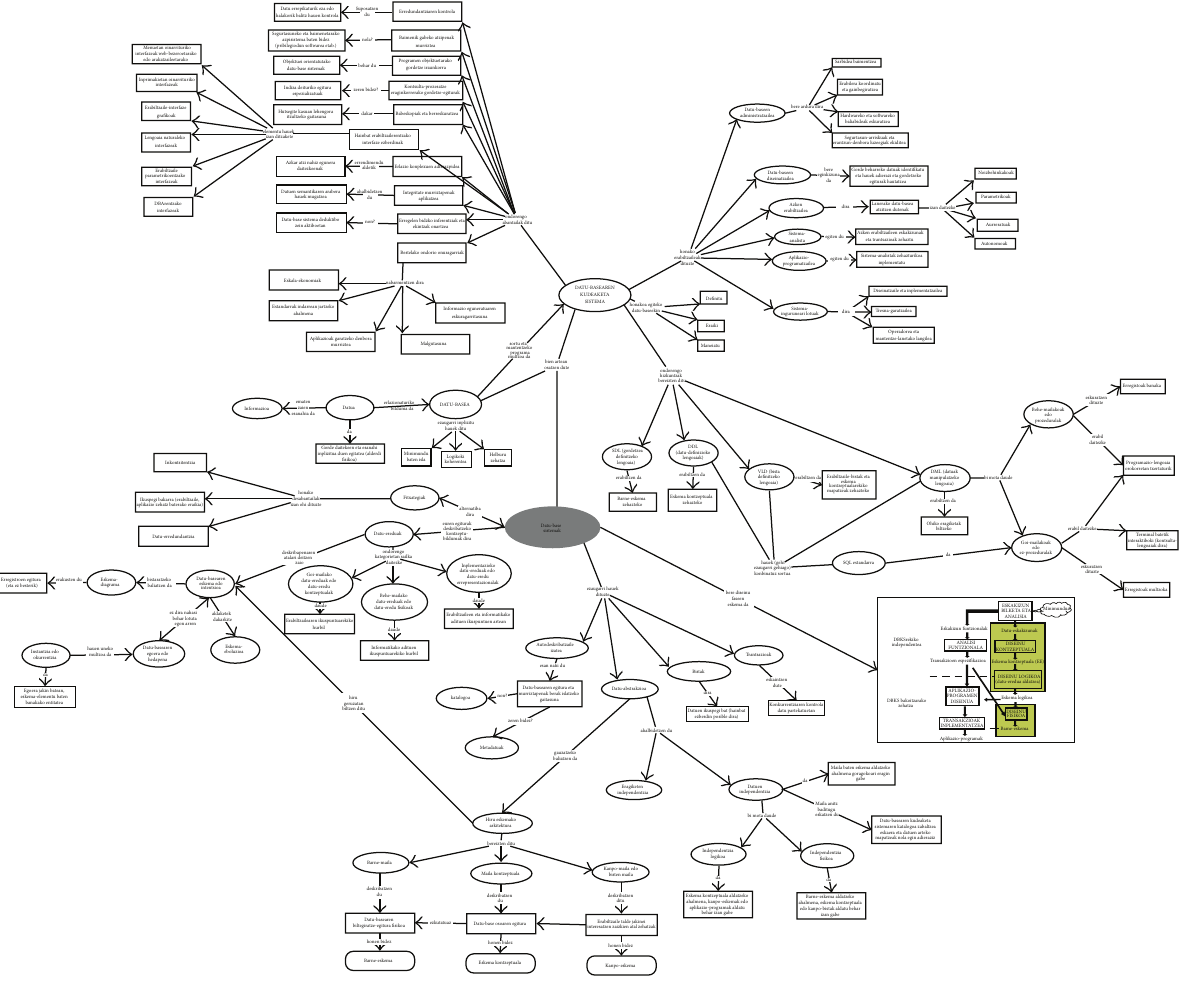
Figure 2: Concept map with the largest number of domain topics.